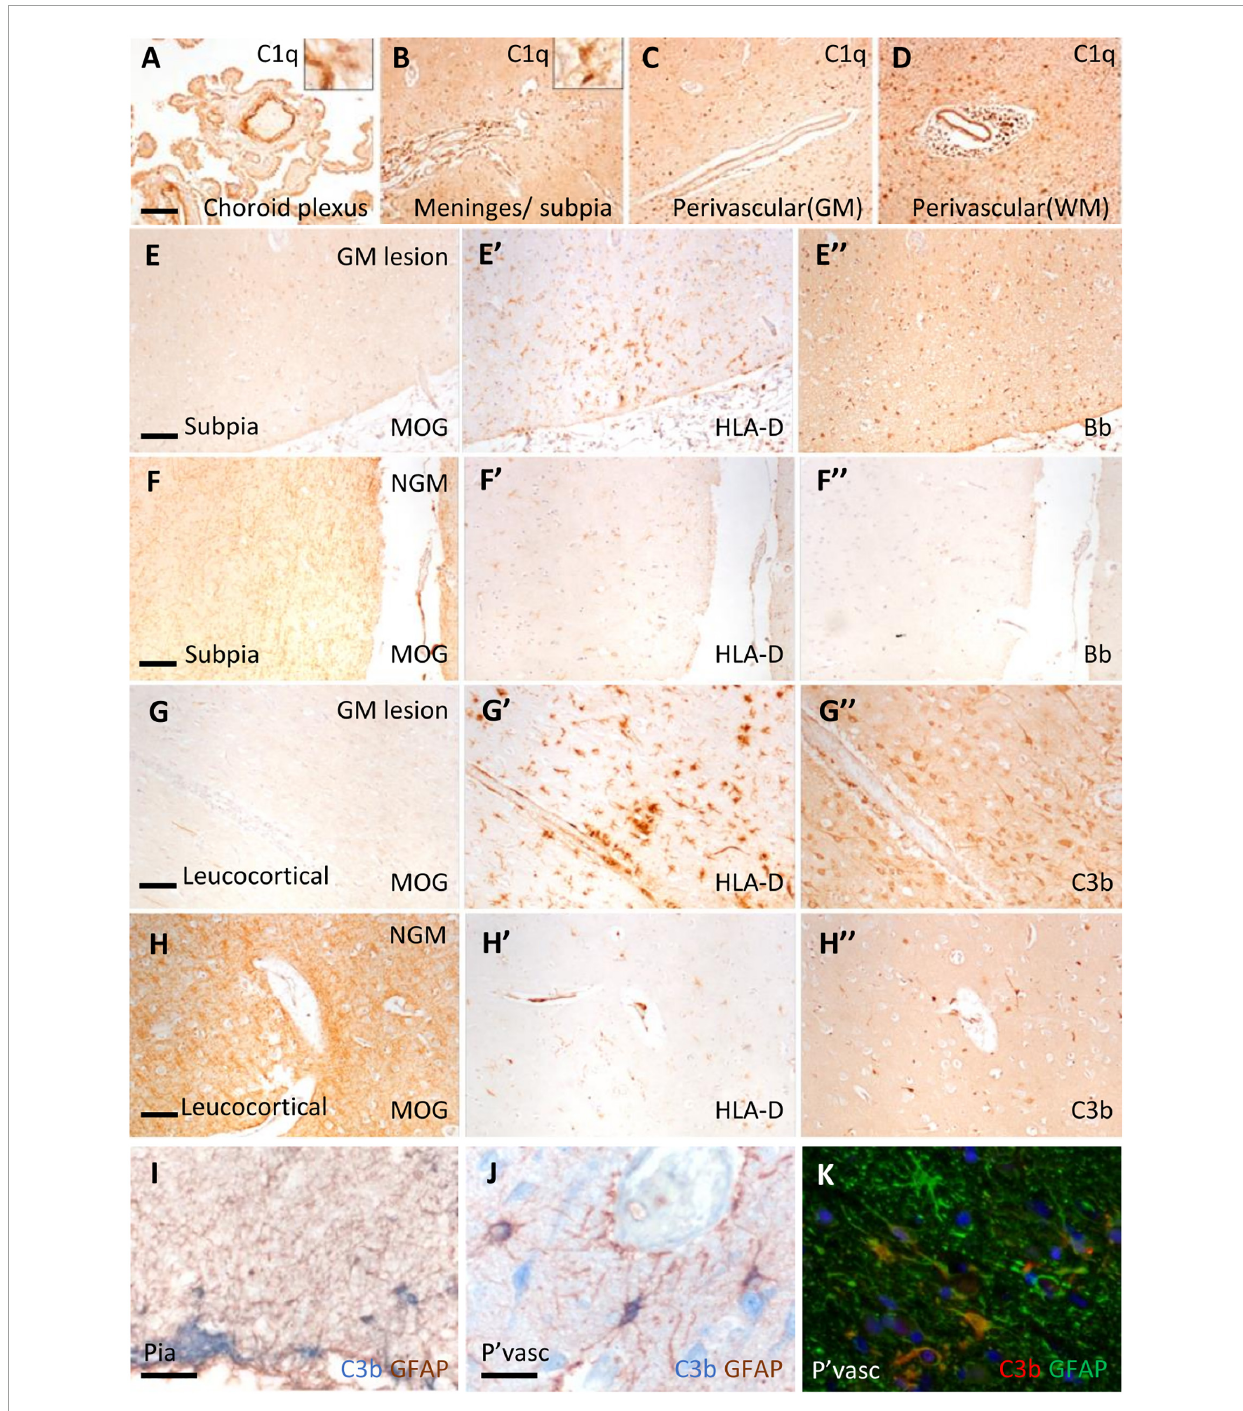
FIGURE1 Complement recognition molecule C1q and activation products decorated brain barriers of the choroid plexus, leptomeninges, and perivascular spaces. Representative example of C1q immunostaining of the choroid plexus, leptomeninges, and perivascular cuffs and more diffusely in the tissue parenchyma of both the white (WM) and grey matter (GM; A–D ). Complement Bb (E–F”) , and C3b (G–H”) immunoreactivity was elevated at sites of subpial and leukocortical GM lesions in comparison to normal appearing GM (NAGM; MOG and HLA-D immunostaining) from the same case (E–E”) . Dual-immunostaining revealed C3b + subpial astrocytes (GFAP+) and neuron-like cells at the glial-limitans at vascular and subpial sites (I,J) . C3b + /GFAP + astrocytes in the deeper laminae of the cortical GM (K) . Scale bars panels (A–D) = 100 µ m; panels (E–I) = 50 µ m; panels (J,K) = 25 µ